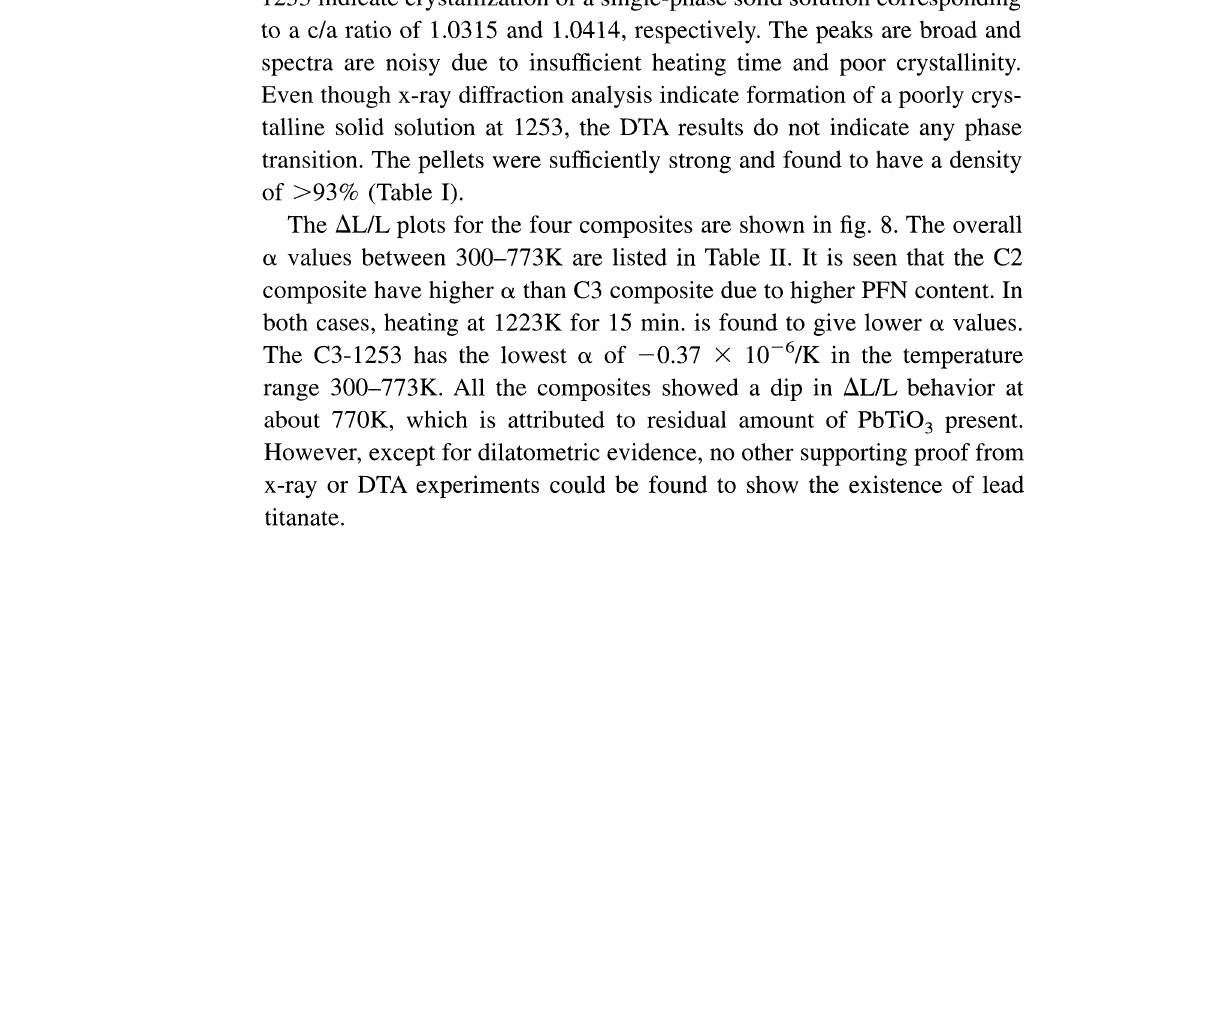
FIGURE 6 Expected behavior of AL/L for the intermediate composites in the PT]_xPFNx system.